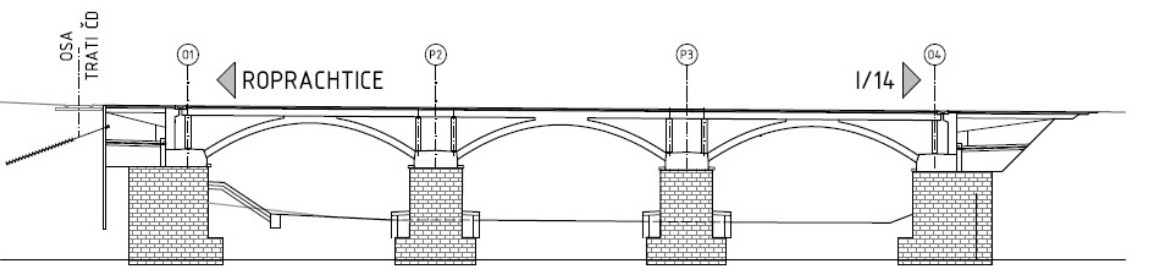
Figure 2. New design of the